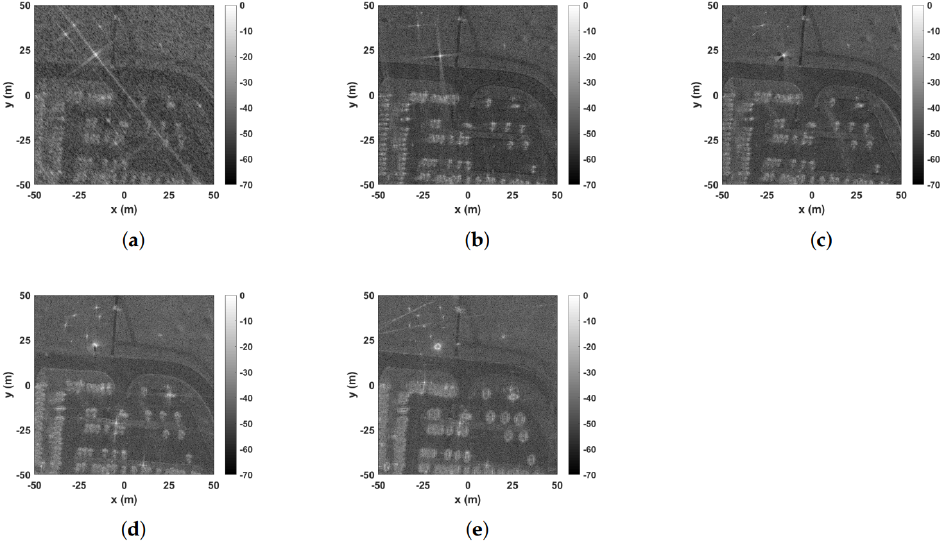
Figure 13. Images generated using the fast-factorized backprojection algorithm and the Gotcha Volumetric SAR dataset at different azimuth angles: 39º, 1–10º, 1–50º, 1–100º and 1–360º. ( a ) GOTCHA Volumetric dataset image generated using the fast-factorized backprojection algorithm at 39º azimuth. ( b ) GOTCHA Volumetric dataset image generated using the fast-factorized backprojection algorithm from 1º to 10º azimuth. ( c ) GOTCHA Volumetric dataset image generated using the fast-factorized backprojection algorithm from 1º to 50º azimuth. ( d ) GOTCHA Volumetric dataset image generated using the fast-factorized backprojection algorithm from 1º to 100º azimuth. ( e ) GOTCHA Volumetric dataset image generated using the fast-factorized backprojection algorithm from 1º to 360º